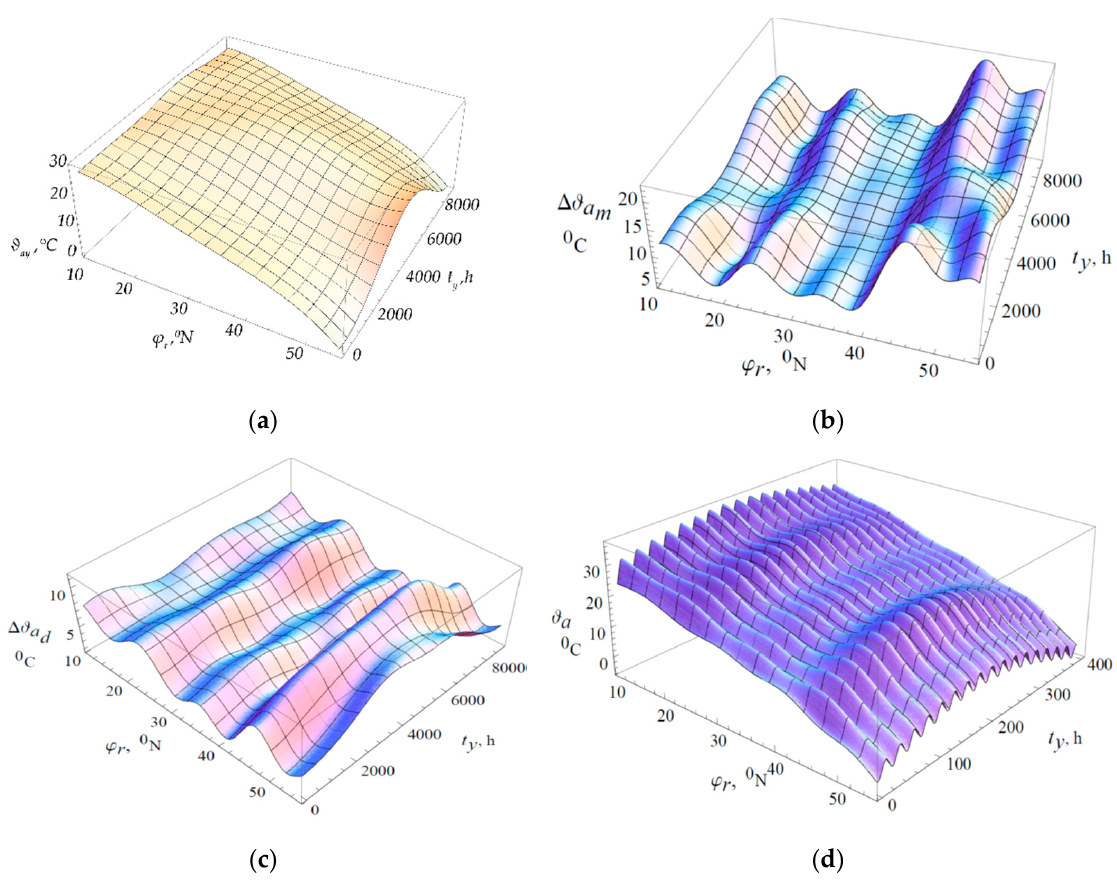
( ϕ r , t ) . ( ϕ r , t ) , ( b ) ∆ ϑ a ( ϕ r , t ) , ( c ) ∆ ϑ a ( ϕ r , t ) , ( d ) ϑ a Y Y Y Y m Y d d